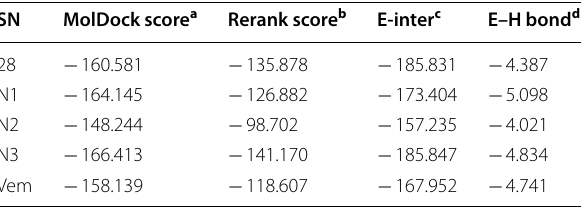
a Moldock score was obtained from the PLP scoring functions with a new H-bond term and extra charge schemes (Molegro 2011) b Rerank score is a linear combination of E-inter (electrostatic, van der Waals, H-bonding, steric) between the ligand and the protein target, and E-intra (electrostatic, van der Waals, H-bonding, sp2–sp2, torsion) of the ligand weighted by pre-defined coefficients (Molegro 2011) c E-inter is the total interaction energy between the protein and the pose d E–H bond is H bond